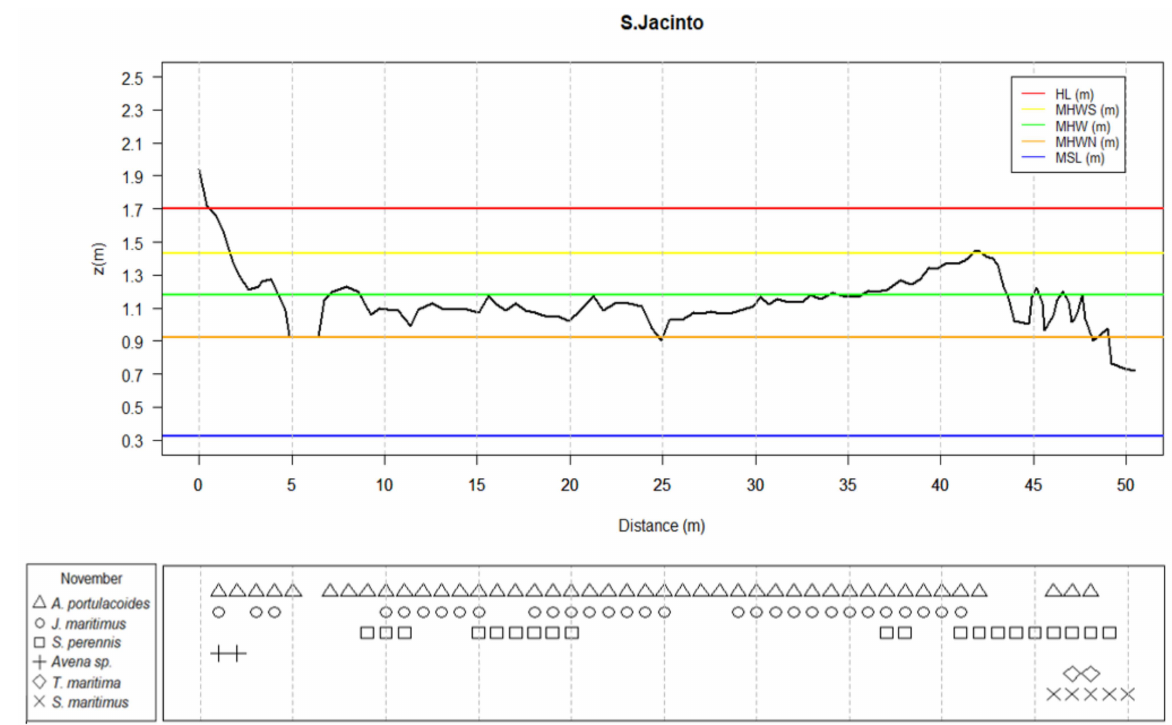
Figure 3. Topographic profile of S ã o Jacinto’s salt marsh transect ranging from its upper limit at land to its lower border near water (black line) and its respective tidal levels, along with the vegetation distribution for November through the transect length.